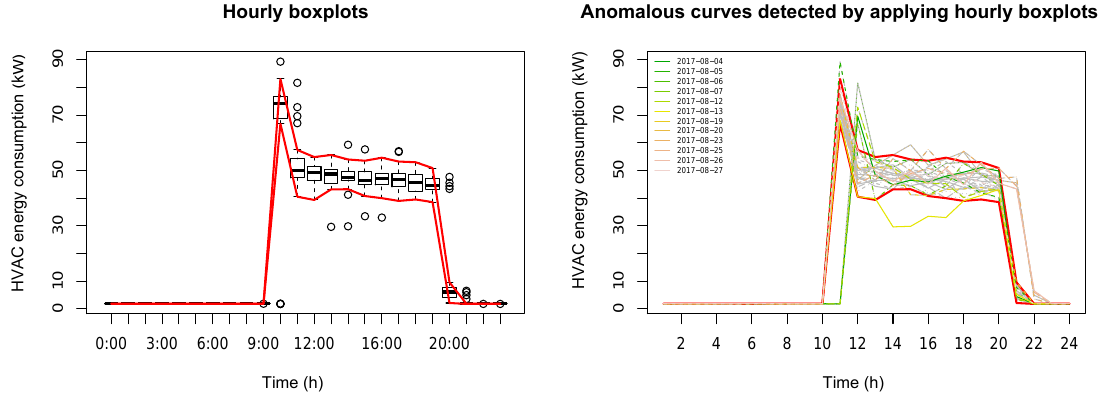
Figure 2. Detecting outliers in the heating, ventilation and air conditioning (HVAC) energy consumption by developing a boxplot for energy consumption per